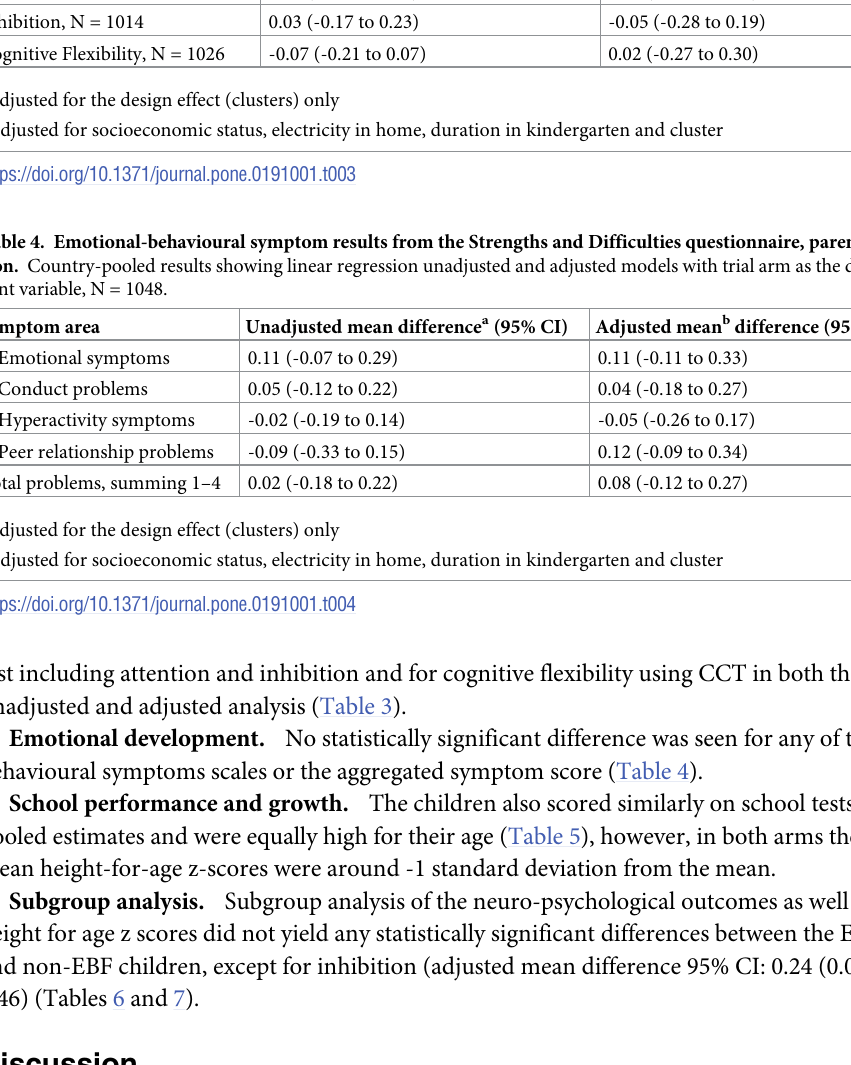
Table 5. Average school test results and height for age z-scores (HAZ) by intervention and control arms. Height for age z-scores (both